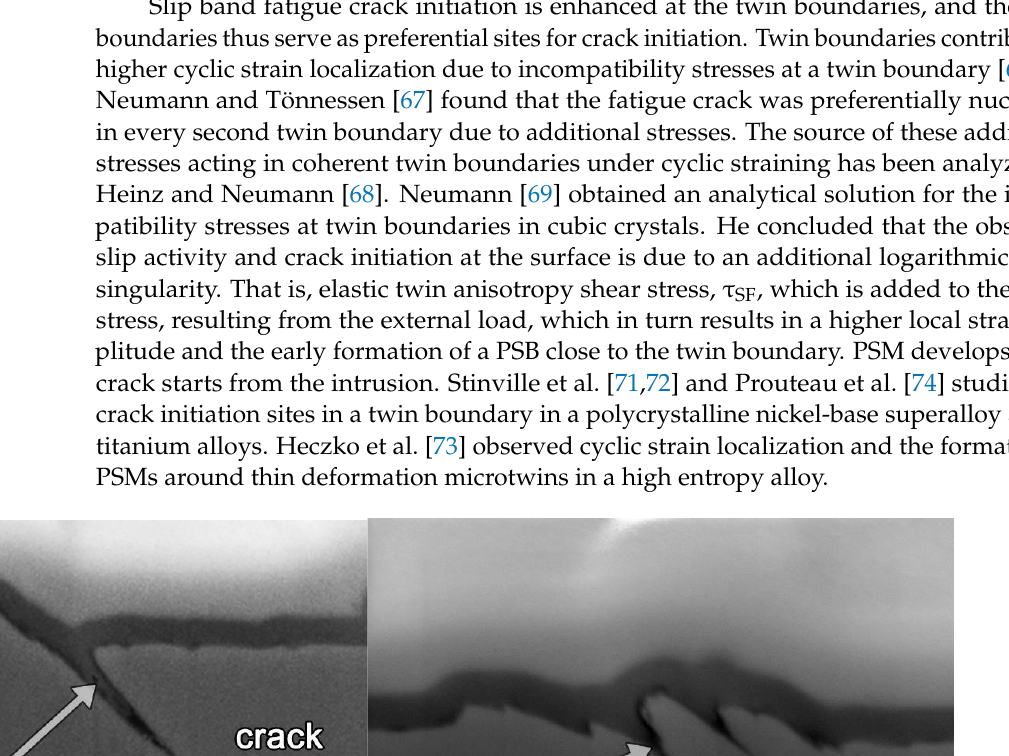
Figure 16. TEM image of the lamella prepared from the surface of fatigued Sanicro 25 steel showing two PSMs with short cracks starting from intrusions. Slip band fatigue crack initiation is enhanced at the twin boundaries, and the twin boundaries thus serve as preferential sites for crack initiation. Twin boundaries contribute to higher cyclic strain localization due to incompatibility stresses at a twin boundary [66 – 74]. Neumann and Tönnessen [67] found that the fatigue crack was preferentially nucle- ated in every second twin boundary due to additional stresses. The source of these